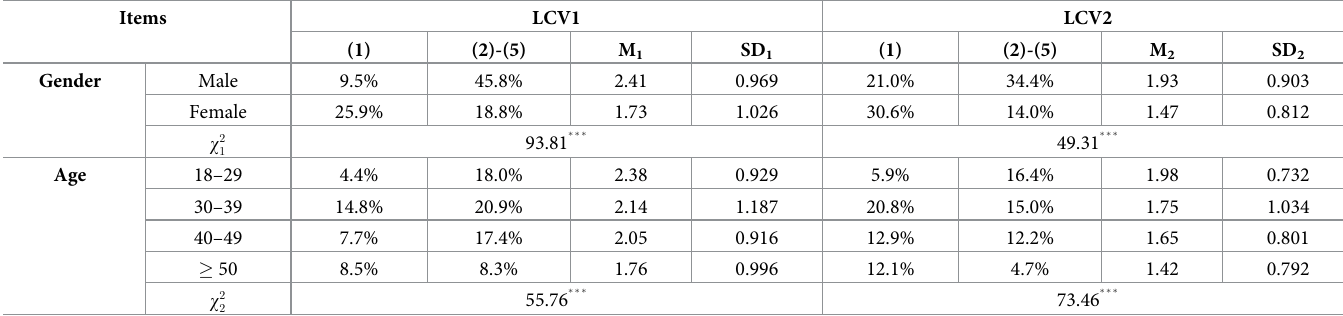
Table 5. Self-reported lane change violation behavior by gender and